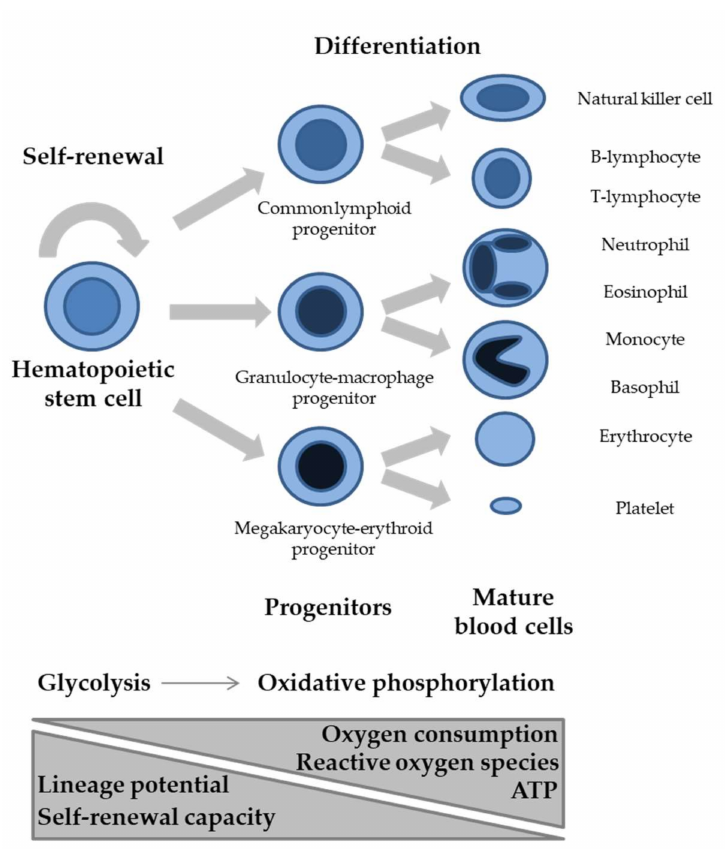
Figure 1. Simplified diagram of hematopoiesis, with selected cells provided as examples. ATP: adenosine